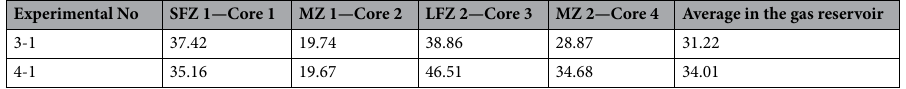
Experimental No